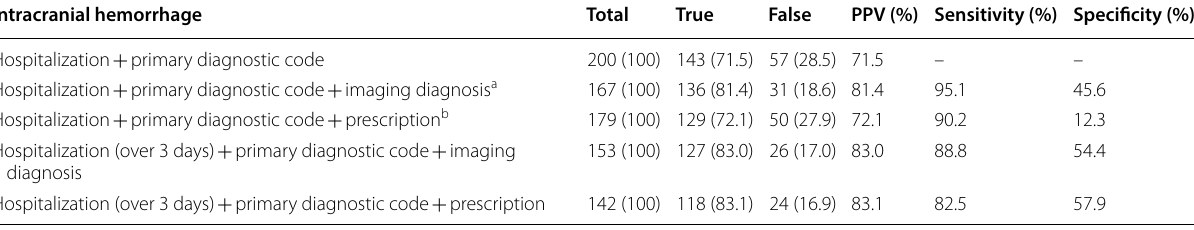
PPV positive predictive value a Brain imaging studies including a computed tomography (CT) scan or a magnetic resonance imaging